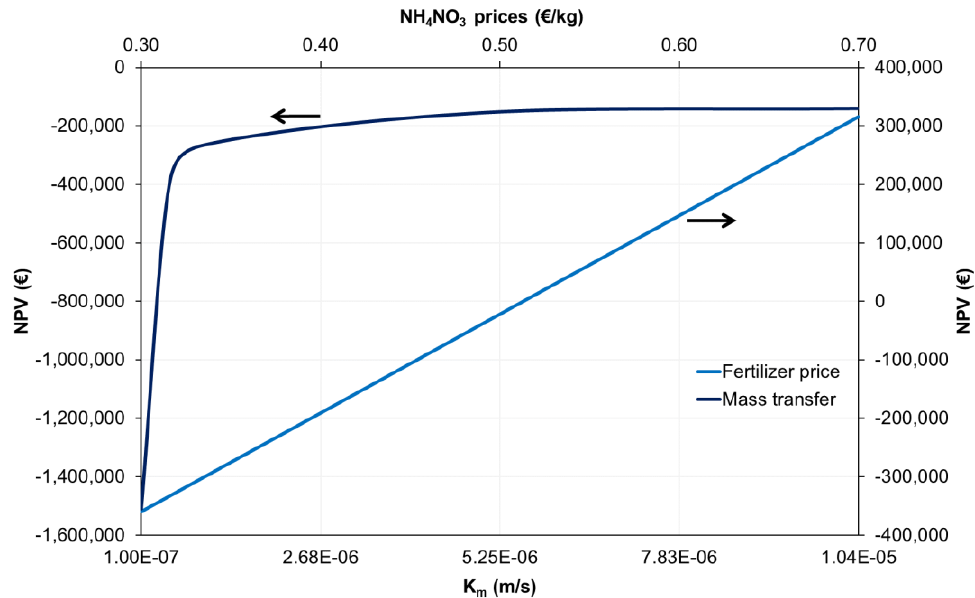
Figure 8. Sensitivity analysis for the NH 4 NO 3 prices and mass transfer coefficient (K m ). The arrows indicated the y-axis corresponding to each line of the graph.